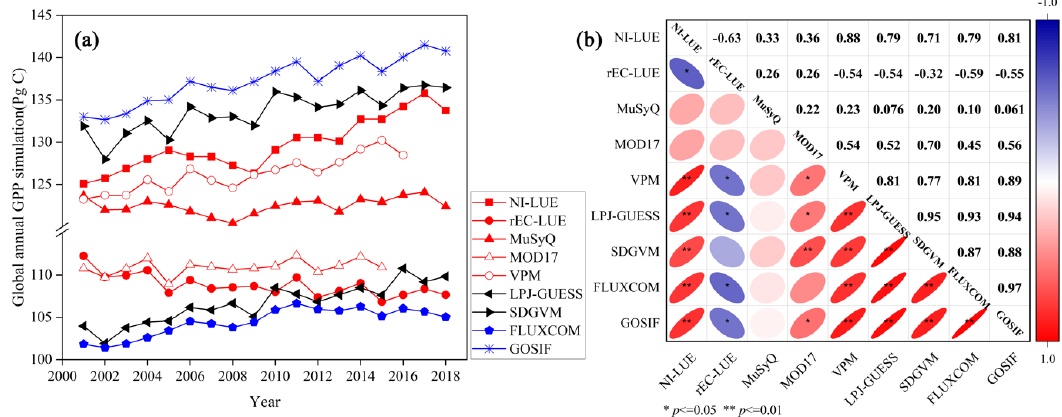
Figure 13. (a) Comparisons of global annual total GPP from different products; (b) correlation coef- Figure 13. ( a ) Comparisons of global annual total GPP from different products; ( b ) correlation ficient matrix of inter-annual variations of total GPP of different products. coefficient matrix of inter-annual variations of total GPP of different products. To demonstrate that the spatial pattern of NI-LUE GPP products was reasonable, we separately calculated the SPAEF between the mean annual NI-LUE GPP and different GPP products. Figure 14 showed that the SPAEF of NI-LUE GPP and other products were all above 0.5, and the spatial consistency with rEC-LUE and MuSyQ was the highest, with an SPAEF of 0.86 and 0.83, respectively. Due to the lower spatial resolution of LPJ-GUESS and SDGVM, the spatial consistency with NI-LUE GPP was relatively poor, with an SPAEF of 0.51 and 0.55, respectively.